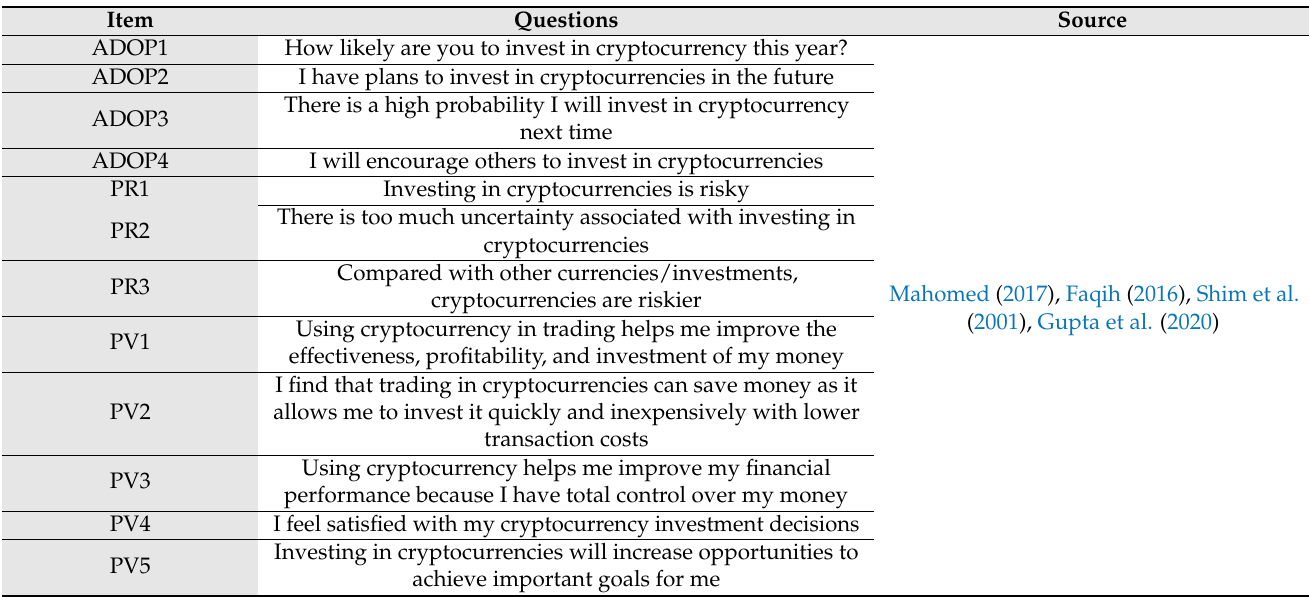
Table 1. Items for construct and their